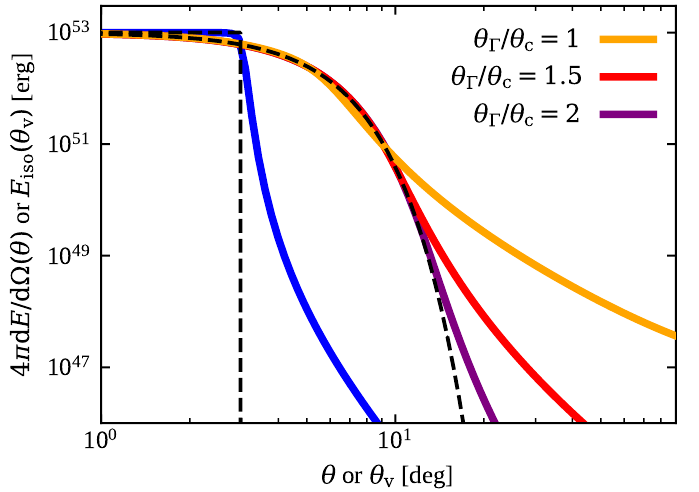
Figure 5. Apparent and intrinsic structure for a uniform and a Gaussian structured jet. Black dashed lines represent 4 π d E /d Ω at an angle θ = θ v from the jet axis. Colored solid lines show E iso ( θ v ) for four different models: a uniform jet model with d E /d Ω = 10 53 /4 π erg and Γ = 300 within an angle θ j = 3 ◦ (blue) and three Gaussian models with d E /d Ω = ( 10 53 /4 π ) exp [ − ( θ / θ c ) 2 /2 ] and ◦ and three different values of θ Γ (orange, red and purple, Γ β = 300exp [ − ( θ / θ Γ ) 2 /2 ] , with θ c = 3 with the corresponding θ Γ / θ c ratios given in the legend). Adapted from